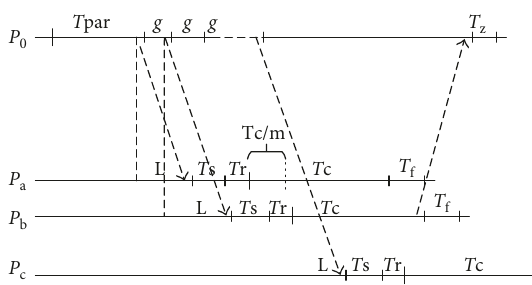
Figure 9: Message delivery on the DPP